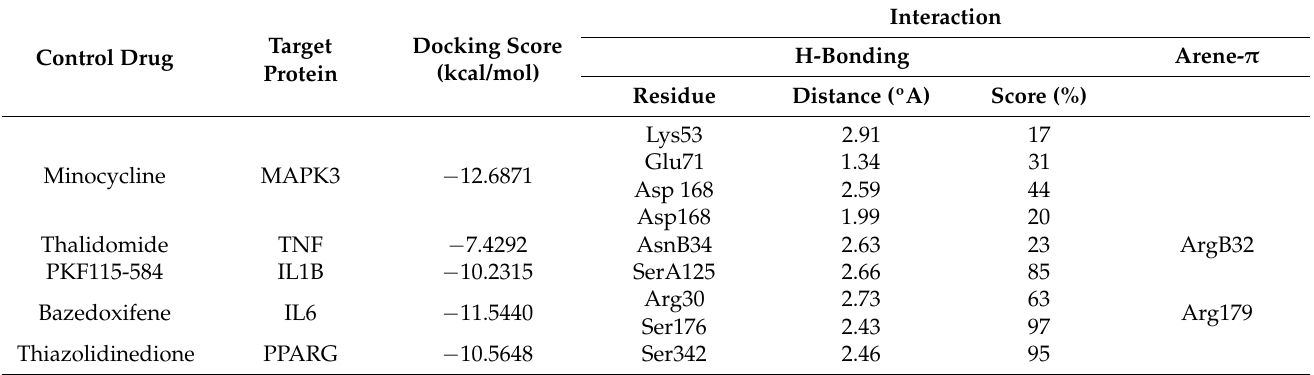
Table 2. Binding mode analysis of positive controls with selected target proteins.